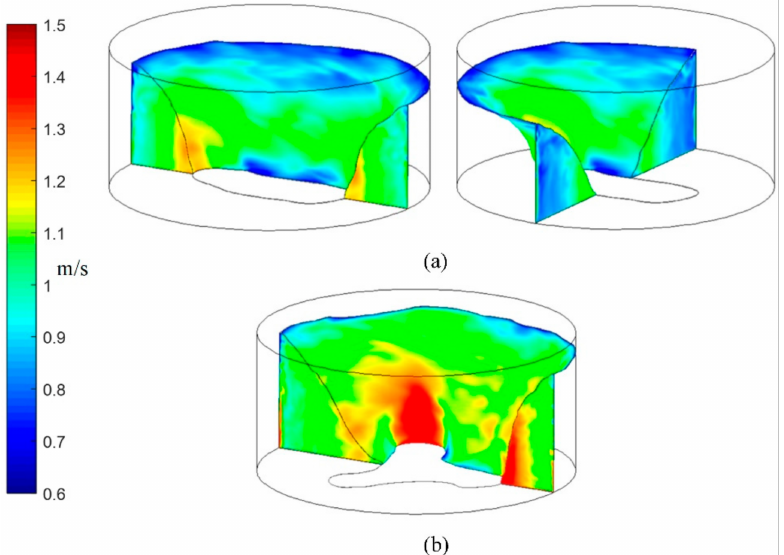
Figure 12. Instantaneous tangential velocity contours: ( a ) elliptical polygon for 3.4 Hz, ( b ) triangular polygon for 4.6